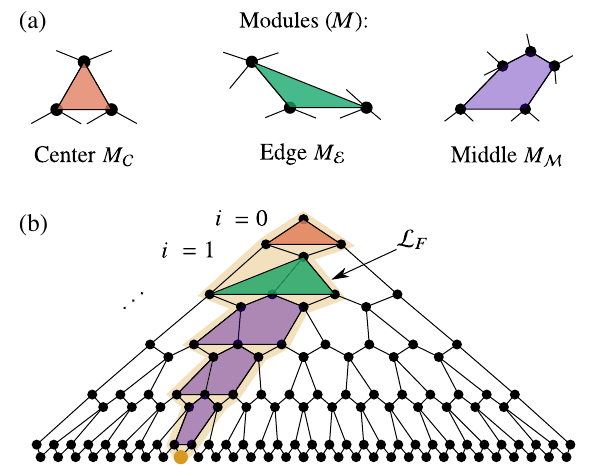
FIG. 3. GRIM modules for the QCNN architecture. (a) Basic modules M from left to right; we refer to these modules as the center M C , edge M E , and middle M M module. Note that while both M C and M E contain three unitaries, their contractions are different. (b) Example of the first step of the GRIM. The forward light cone L of W can be covered with the three basic modules. F Here, W is indicated with a larger colored